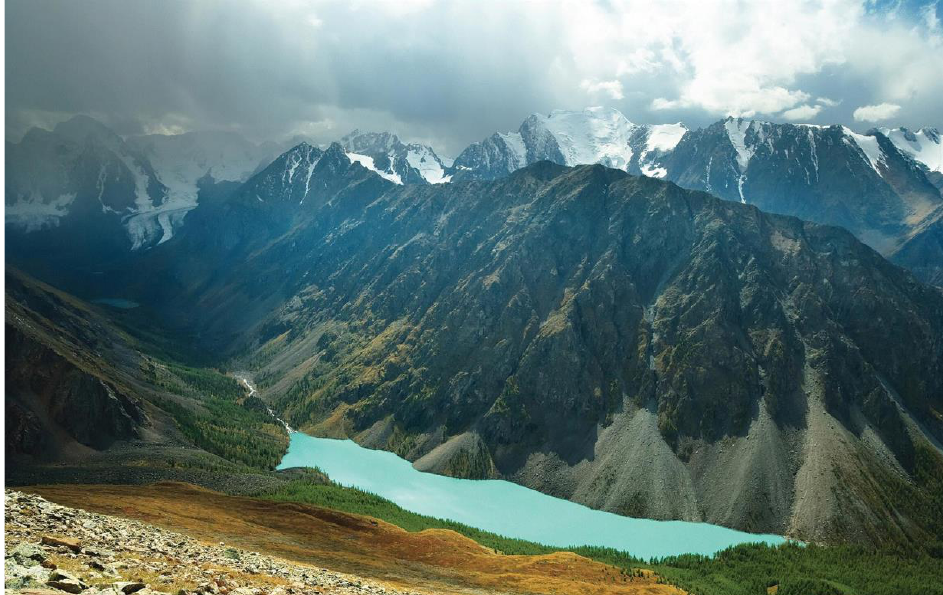
Figure 2. In the mountains, snow, rain, and zero precipitation may occur concurrently at different altitudes (the photo by unknown author shows the Shavla River basin in the Altai Mountains).